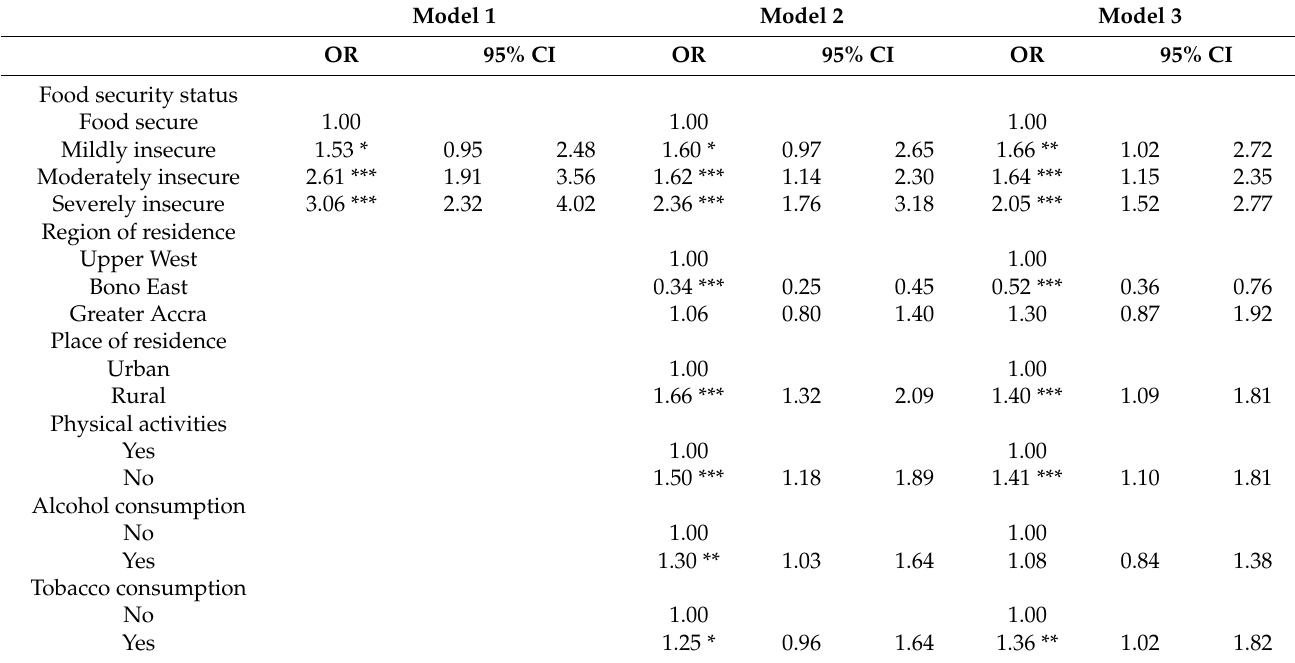
Table 2. Logit models predicting self-rated oral